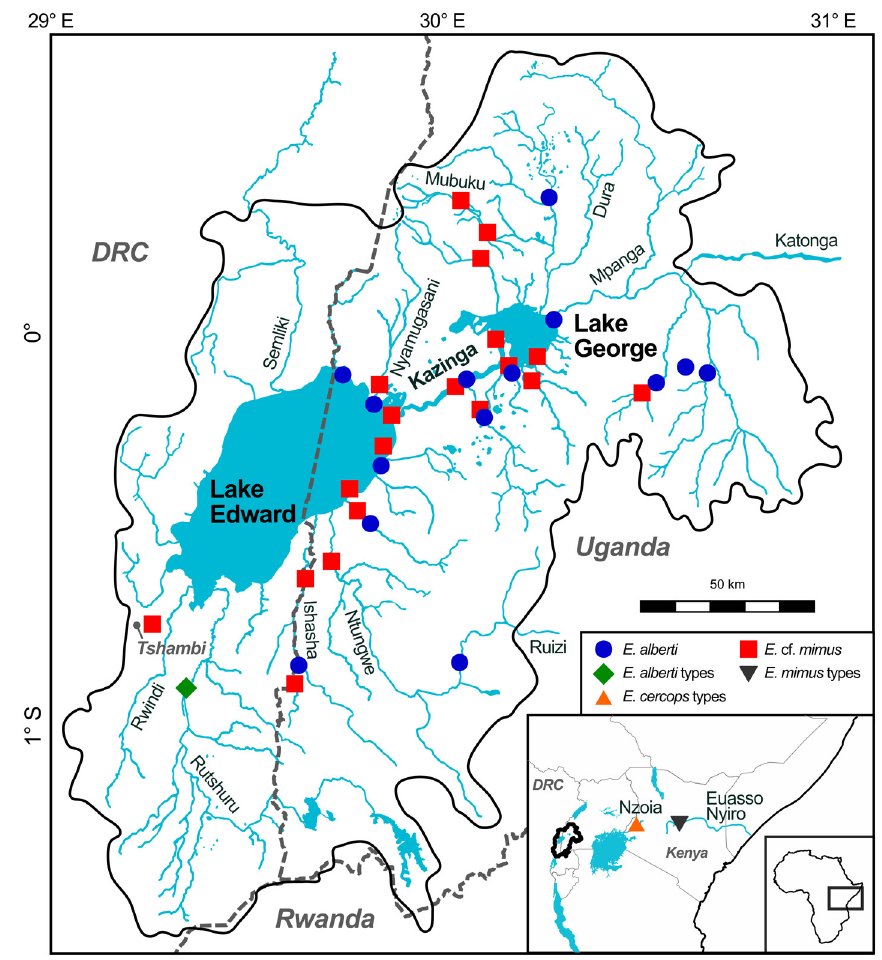
Fig. 10. Overview of the sample locations of E. alberti (Poll. 1939) (●) and E. cf. mimus (Boulenger, 1912) (■), including the specimens from Tshambi, in the Lake Edward system. The location of the lectotype and the paralectotypes of E. alberti (♦). The approximate location of the lectotype and the paralectotypes of E. mimus (Boulenger, 1912) ( ▼ ) and the holotype and paratypes of E. cercops (Whitehead, 1960) ( ▲ ) are indicated in the